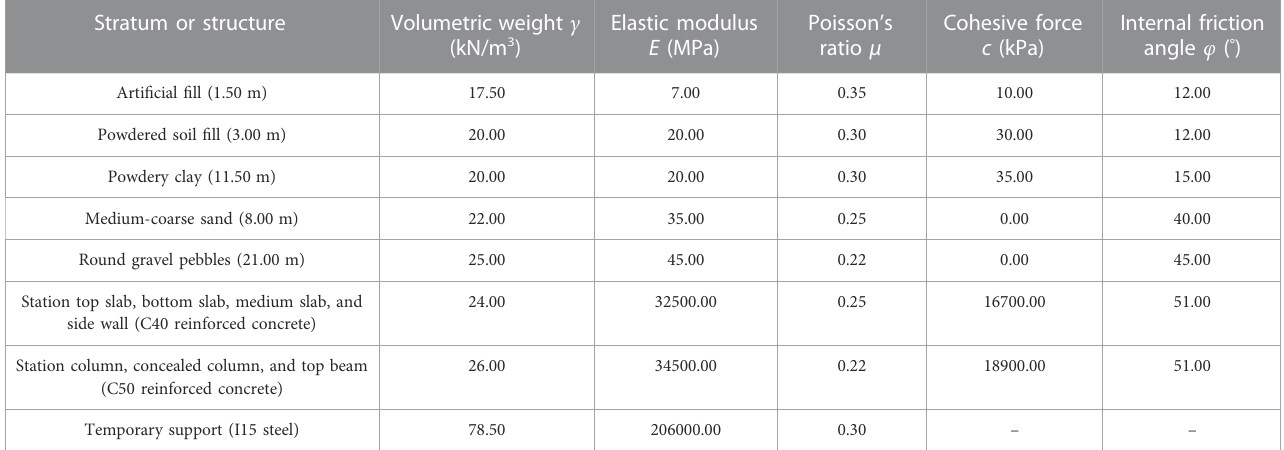
TABLE 1 Mechanical parameters of the strata and station structure.